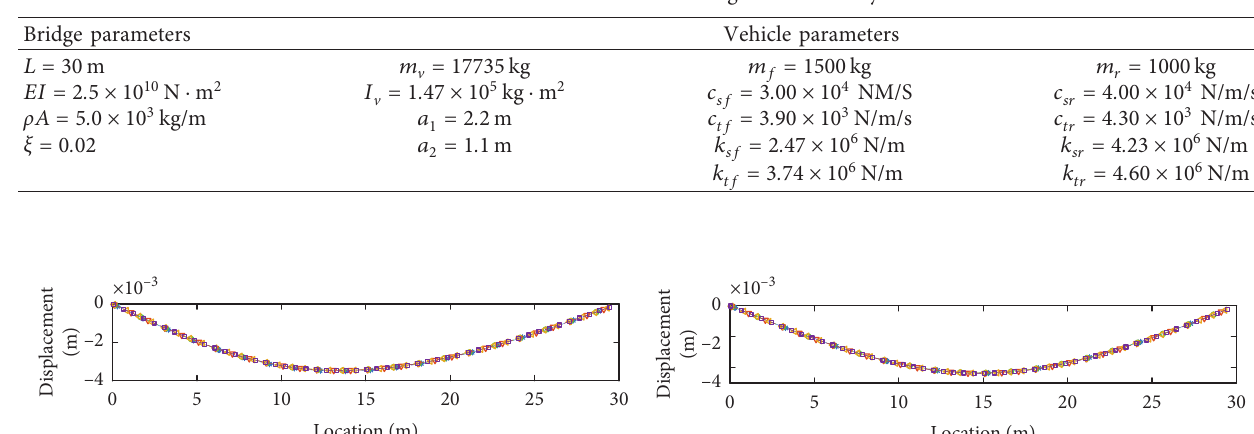
Table 4: Parameters for the vehicle-bridge interaction system.